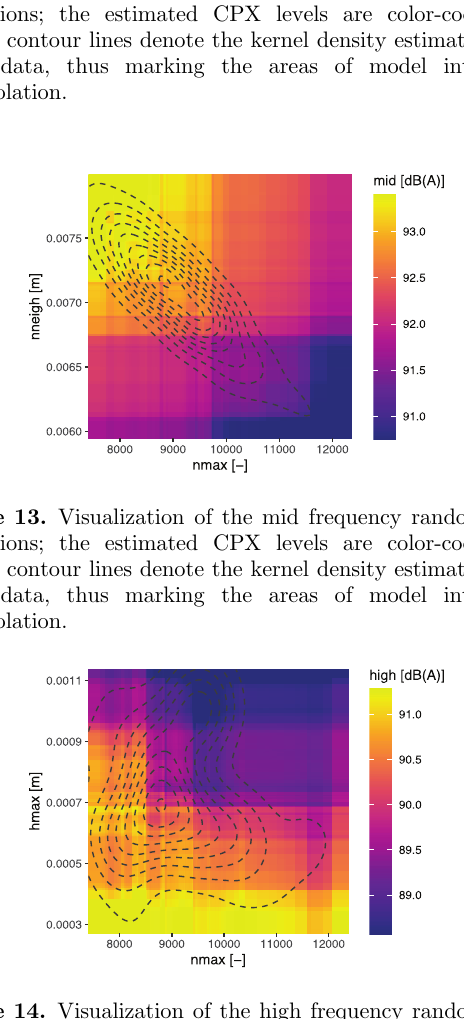
Figure 14. Visualization of the high frequency random forest predictions; the estimated CPX levels are color-coded, the dashed contour lines denote the kernel density estimates of the input data, thus marking the areas of model inter- and extrapolation.